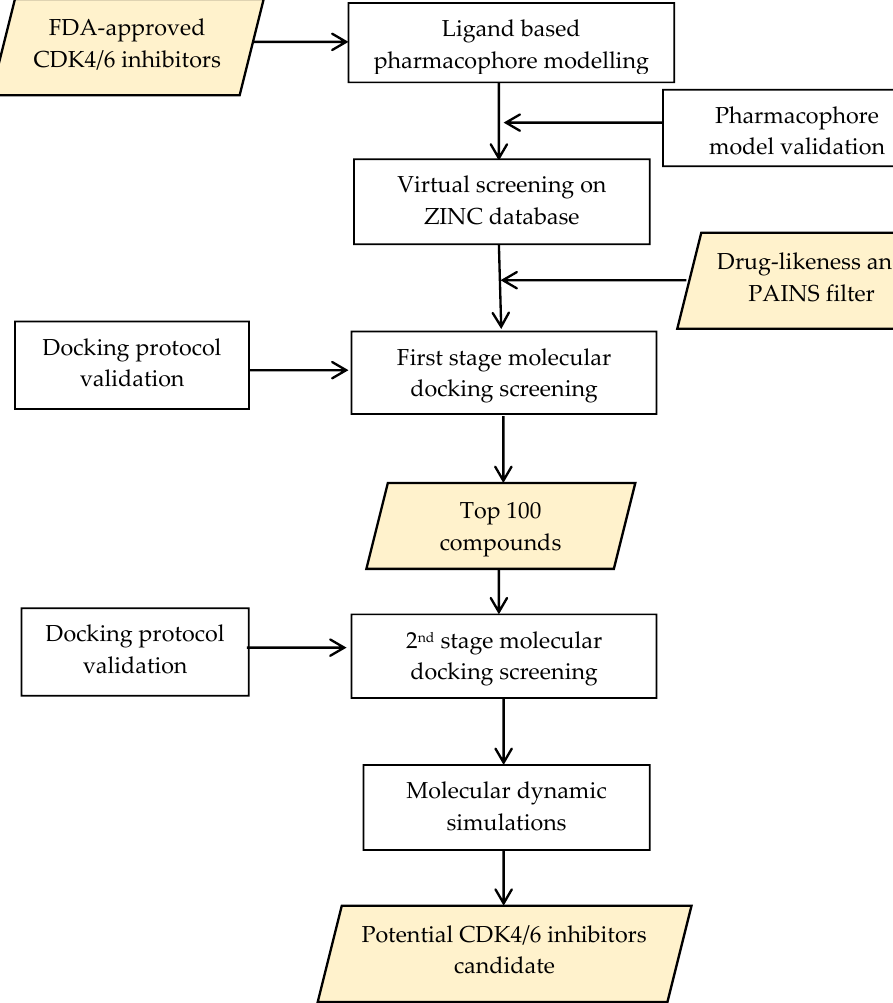
Figure 1. Schematic summarizing the overall workflow described in this work.